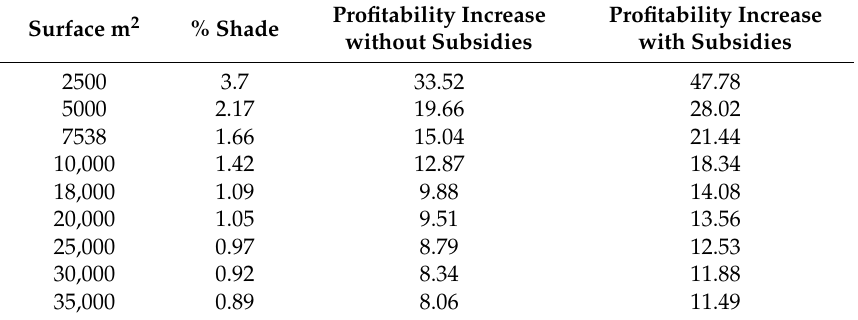
Table 3. Profitability variation depending of greenhouse dimensions (self-consumption